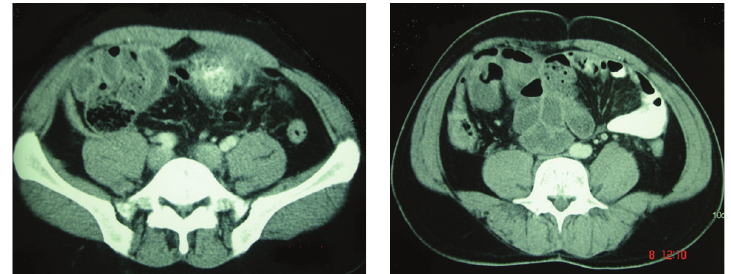
Figure 1: CT showing membrane enveloping loops of small bowel.